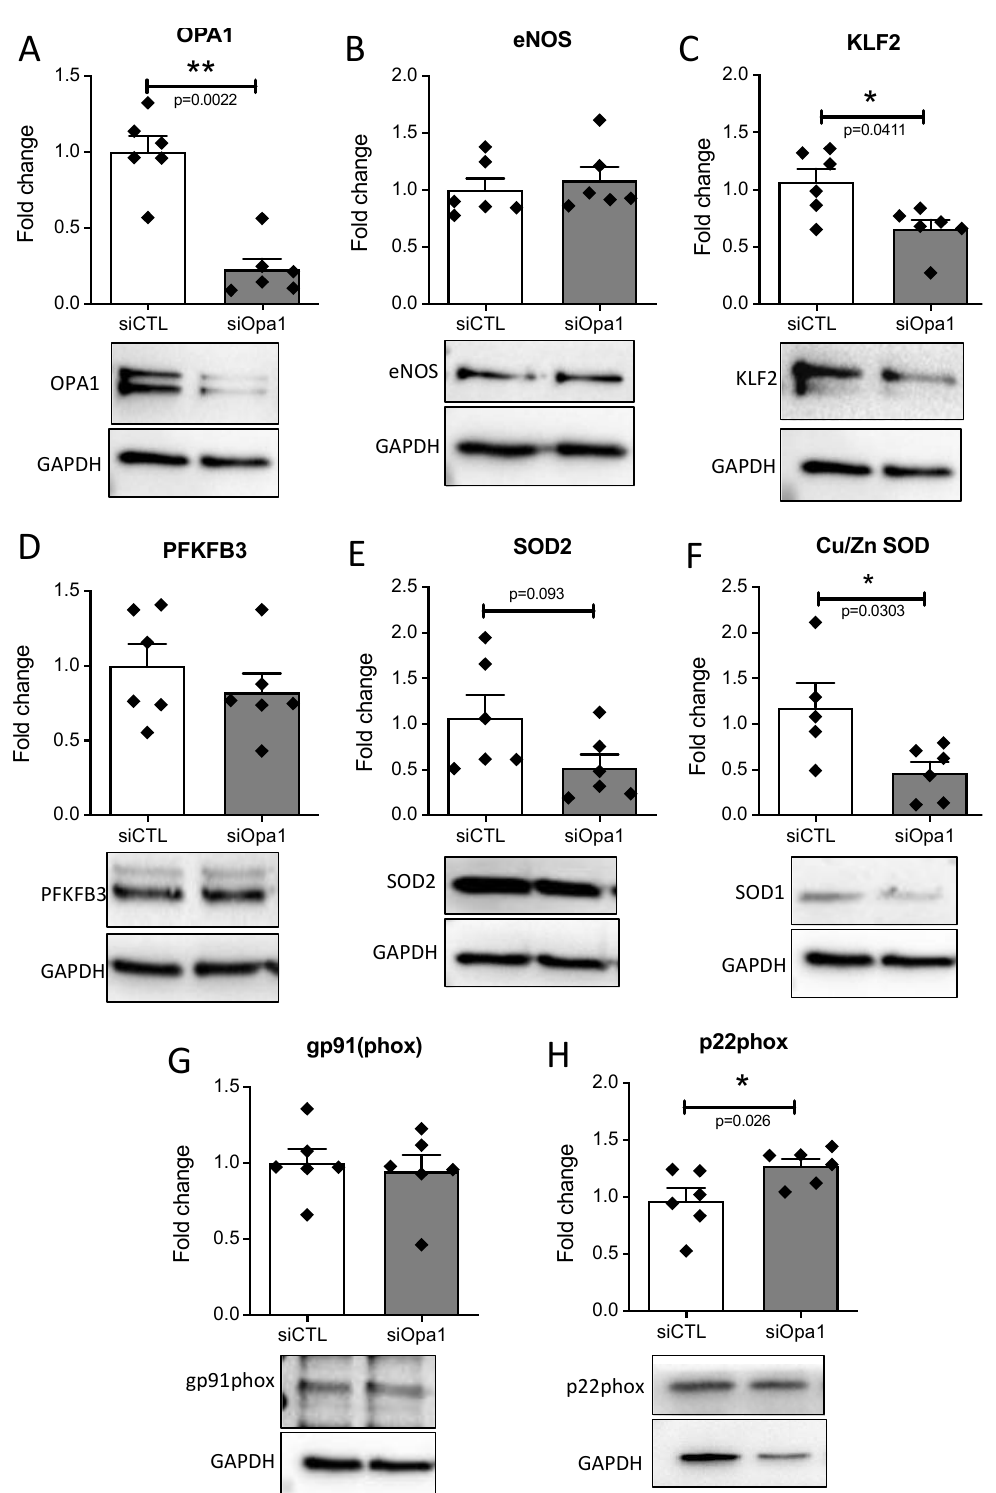
Figure 2. Protein expression measurements in endothelial cells submitted to laminar flow. ( A – H ) Protein expression levels of OPA1, eNOS, KLF2, PFKFB3, SOD2, SOD1, gp91phox, and p22phox were determined in HUVECs submitted to laminar flow using bidi µ -slides for 24h after OPA1 silencing (siOPA1) compared to the control scrambled siRNA (siCONT). Means ± SEM are shown ( n = 6 independent experiments per group). Whole blots are shown in Figures S3 and S4. Two-tailed Mann–Whitney tests, * p > 0.05, ** p < 0.01 ( p -values are shown on the graphs when p <